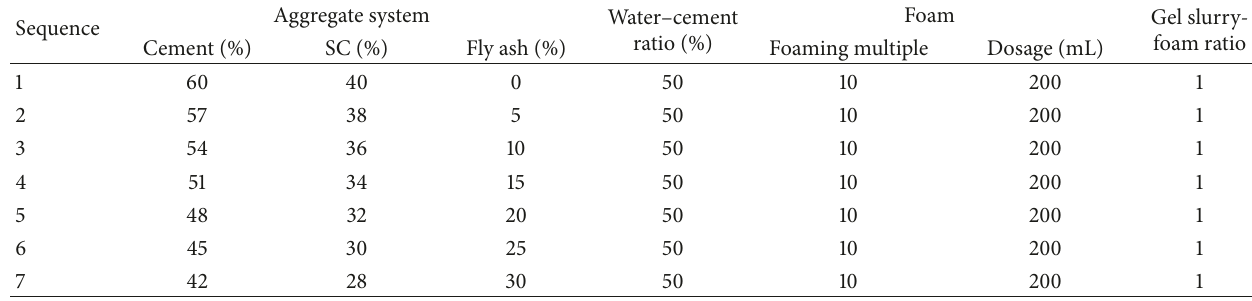
Table 8: Experimental design of the fly ash content.